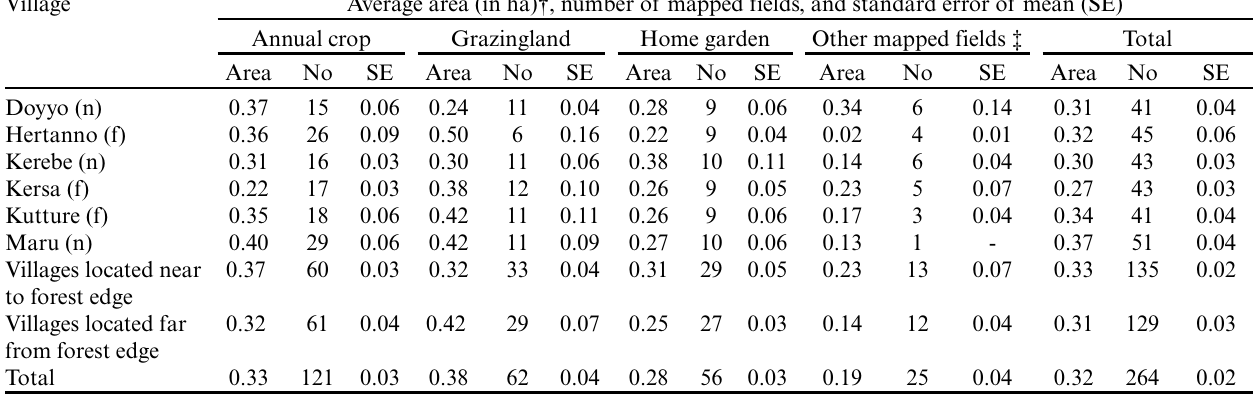
Table 2 . Average size and number of the surveyed fields. † The fields size were obtained in local unit, sanga (8 sanga = 1 ha) through interview. f: Villages located far from forest edge. n: Villages located along forest edge. ‡ Includes 12 cultivated coffee fields, 8 other land uses such as graveyard and mixed land uses, e.g., cereals and coffee, khat ( Catha edulis ), and sugarcane fields, and 5 woodlots mapped fields.